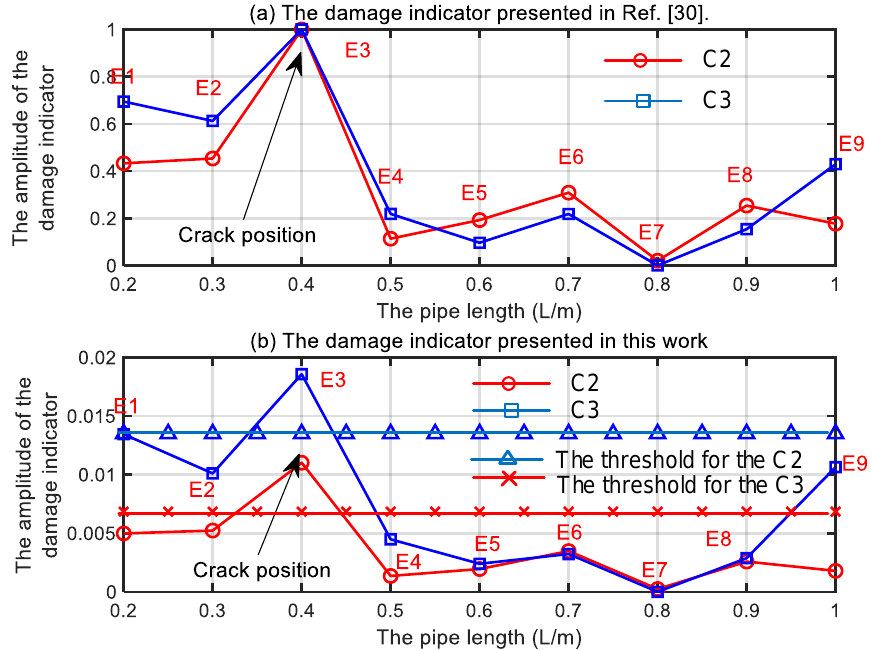
Figure 12. The comparison of the damage indicator from present work with damage indicator from the work of Cui et al.